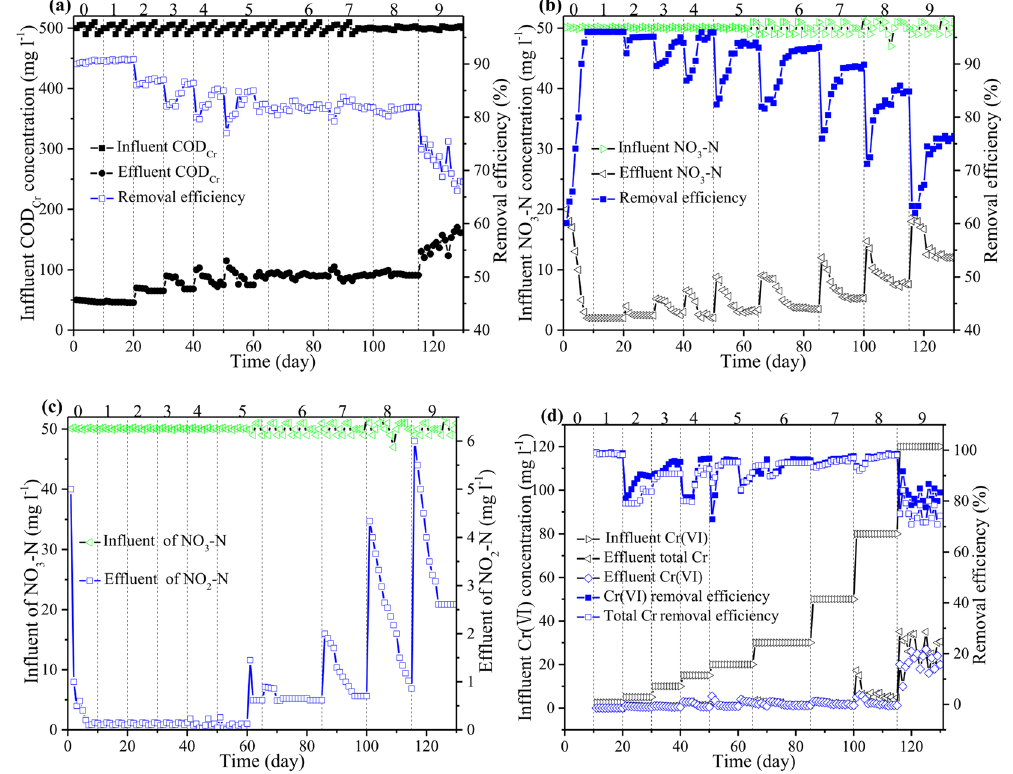
Figure 1. Effect of Cr(VI) on the COD Cr , NO 3 -N, NO 2 -N and Cr(VI) removal in the anaerobic reactor. Variations of ( a ) COD Cr , ( b ) NO 3 -N, ( c ) NO 2 -N and ( d ) Cr concentrations in the influent and effluent under different Cr(VI) concentrations. The Cr(VI) concentrations were 0.0, 2.5, 5.0, 10.0, 15.0, 20.0, 30.0, 50.0, 80.0 and 120.0 mg l − 1 , corresponding to the phase 0, 1, 2, 3, 4, 5, 6, 7, 8, and 9,